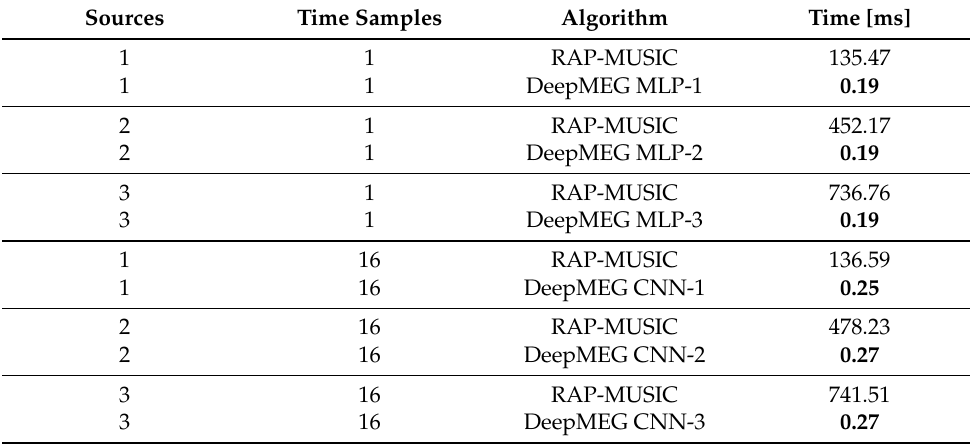
Table 2. Computation Time